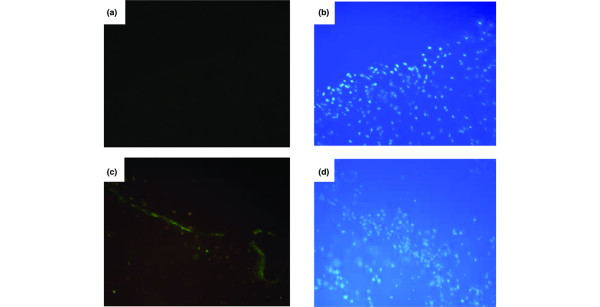
Representative findings of fluorescence microscopy of synovium transferred with FITC-labeled RNODN. (a) Synovium transferred with ribbon-type NF-κB decoy oligodeoxynucleotide (RNODN) not labeled with fluorescein isothiocyanate (FITC). (b) The sections were counterstained with 4',6-diamidino-2-phenylindole. (c) Synovium transferred with FITC-labeled RNODN. Original magnification × 200. (d) The sections were counterstained with 4',6-diamidino-2-phenylindole.